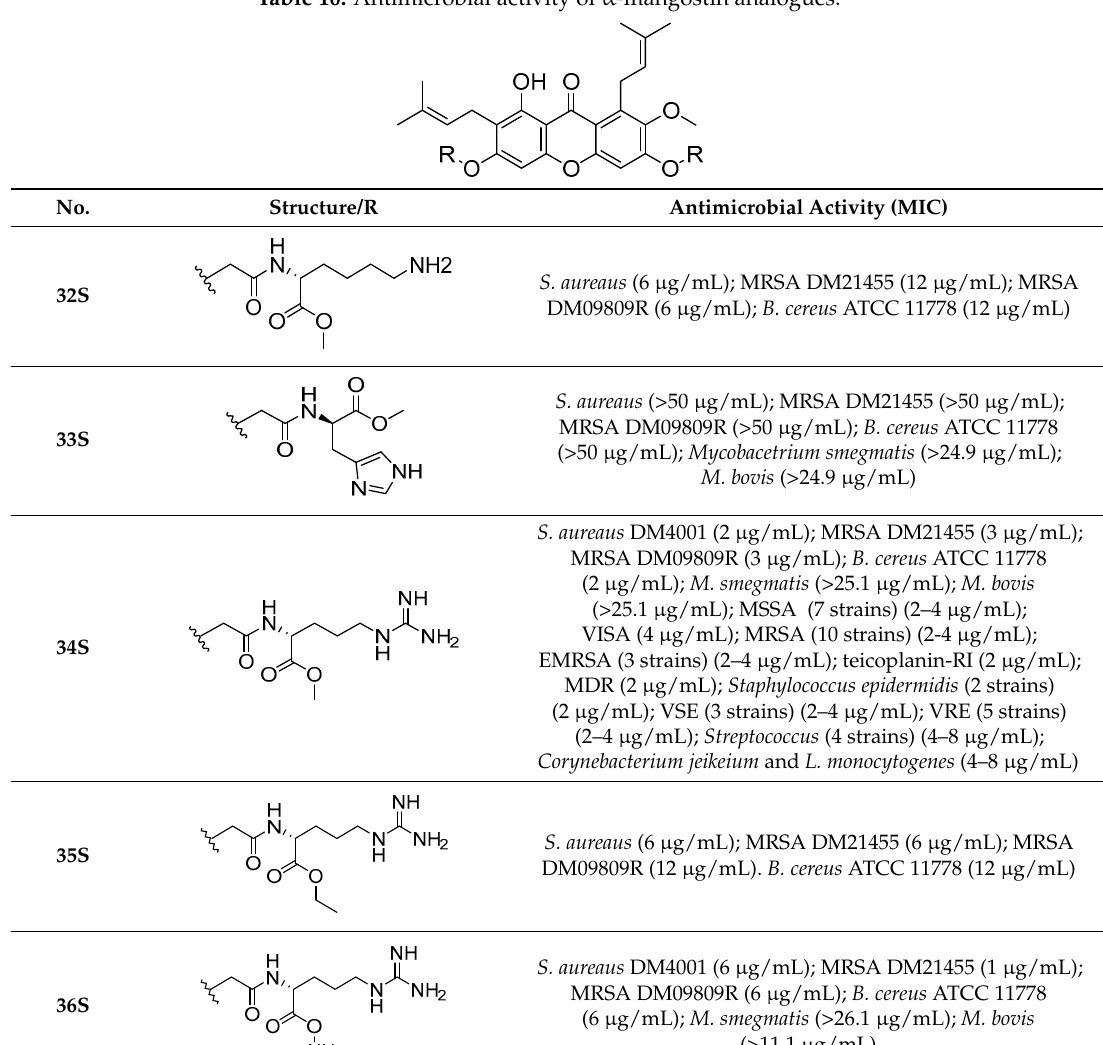
Table 10. Antimicrobial activity of α -mangostin analogues.